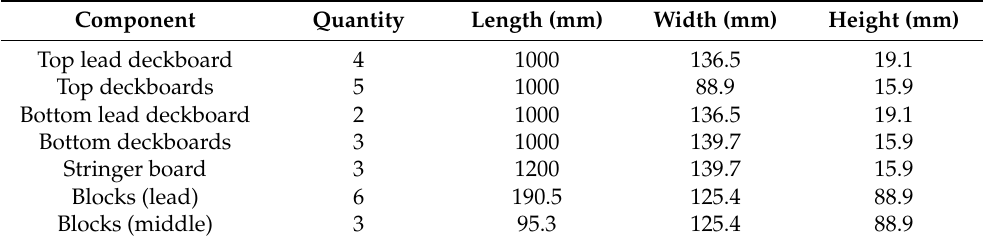
( d ) top; ( e ) side; and ( f ) bottom view of the plastic pallet.